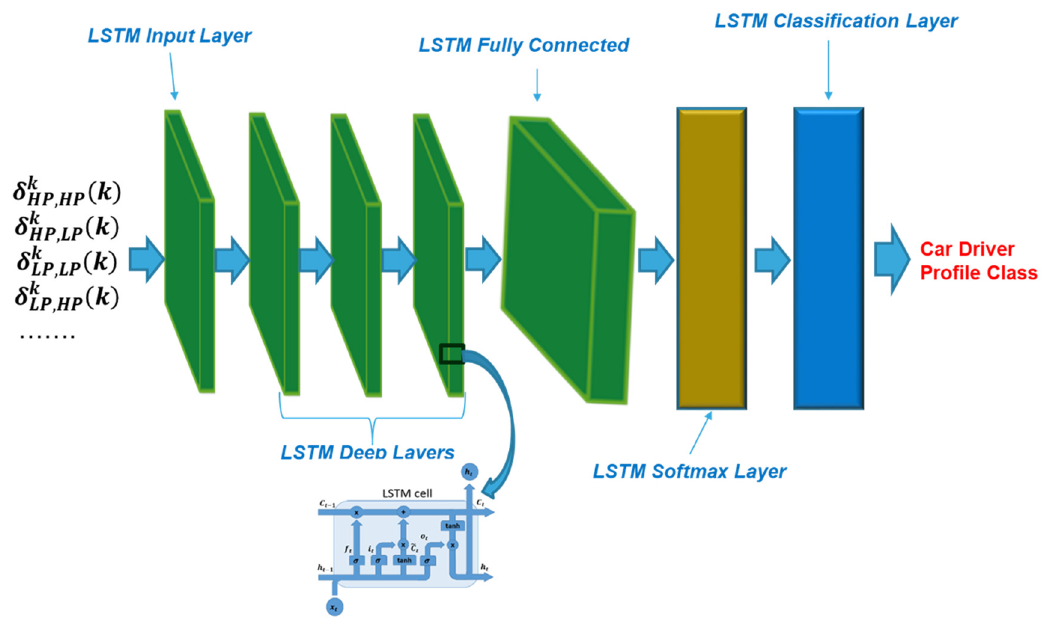
Figure 9. The deep long short-term memory (LSTM) architecture for car-driver identity recognition through the 𝜹 𝒙𝒚𝒌 (𝒌) values.